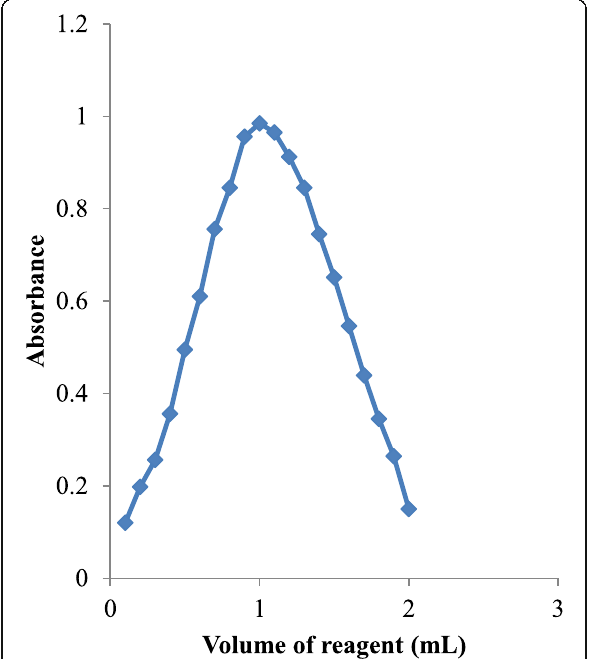
Fig. 3 Job ’ s plot for the determination of stoichiometric reaction between drug and reagent (1:1